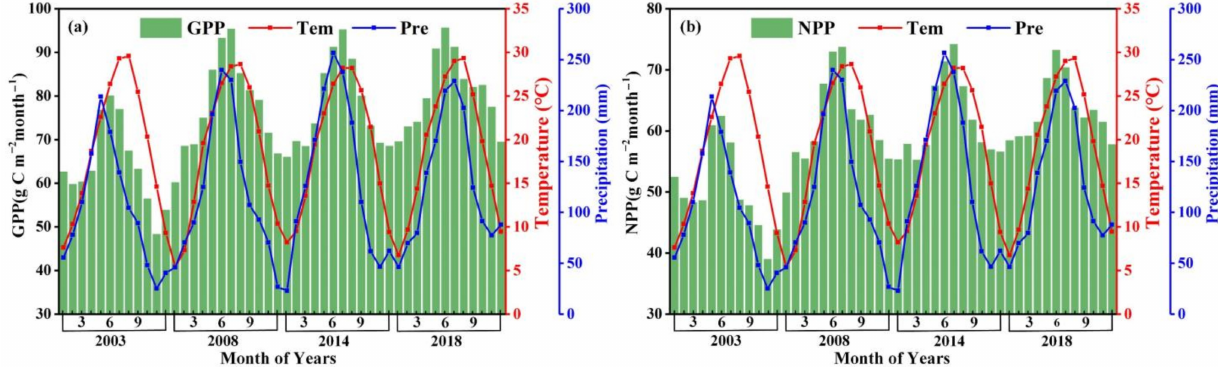
Figure 10. Variation trends of bamboo forests’ ( a ) GPP and ( b ) NPP with temperature and precipita- tion on a monthly